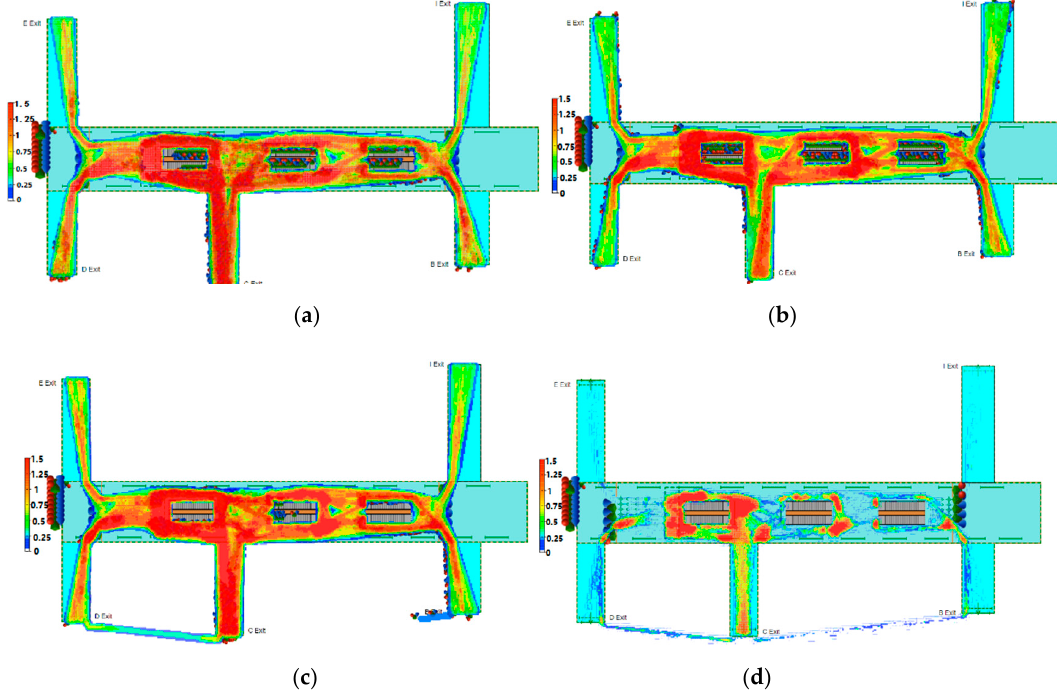
Figure 8. Pedestrian heatmap at different time stamps: ( a ) t=600s, ( b ) t=700s, ( c ) t=800s, ( d ) t=900s.